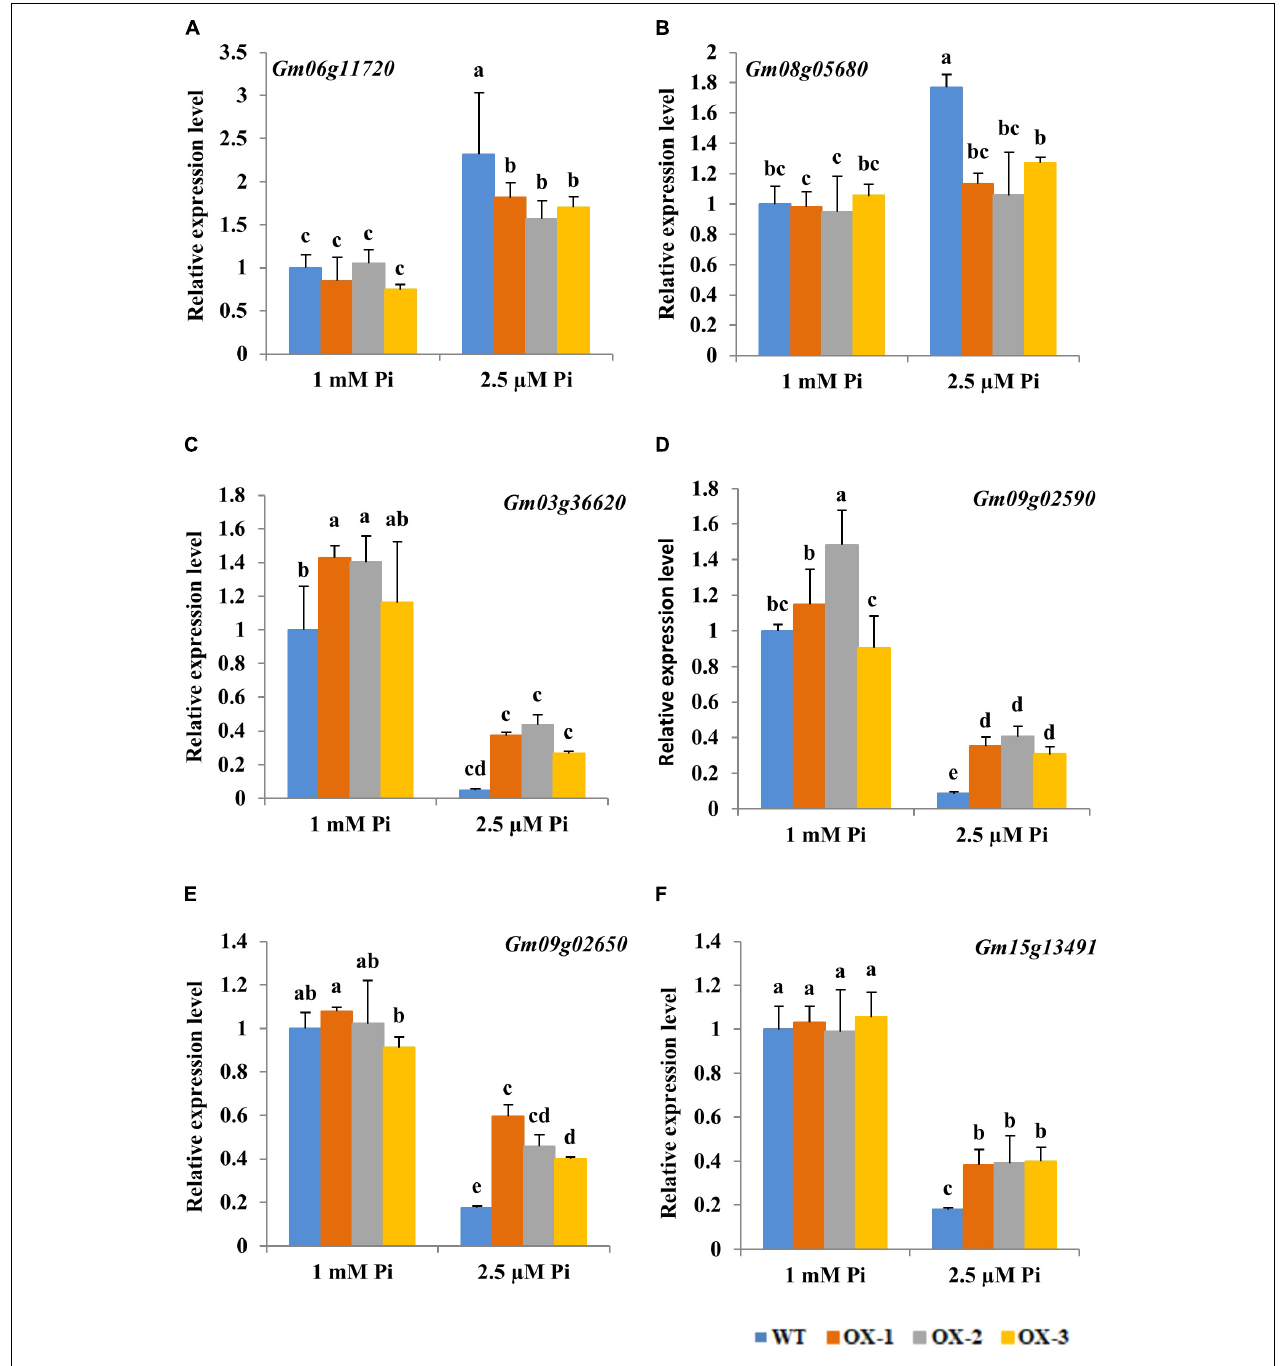
FIGURE 6 | Changes in transcript levels for genes involved in the antioxidant system of soybean root tips during Pi starvation. Five-day-old soybean seedlings (removal of cotyledons) were exposed to nutrient solutions containing two levels of Pi, 1 mM Pi (Pi-sufficient) or 2.5 µ M Pi (Pi-deficient) for 10